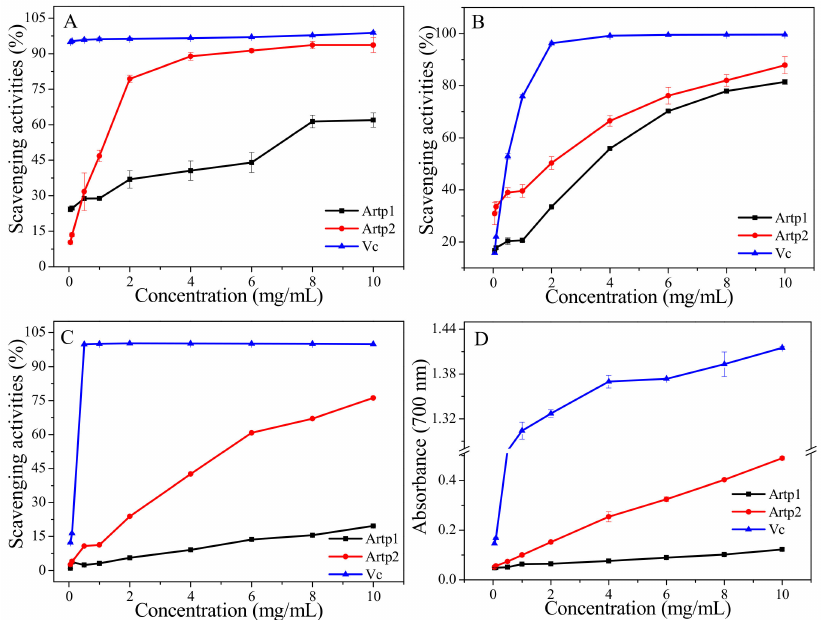
Figure 5. Antioxidant activities of Artp1 and Artp2: ( A ) DPPH radical scavenging activity; ( B ) hy- droxyl radical scavenging activity; ( C ) ABTS radical scavenging activity; ( D ) reducing